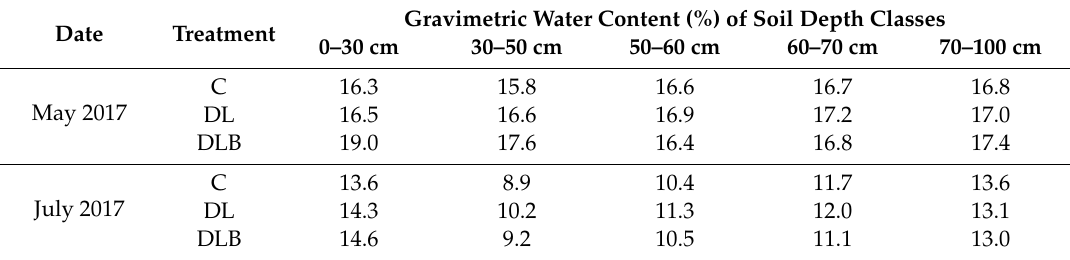
Table 6. Gravimetric soil water content in five soil depth classes. Different letters indicate significant differences within one sampling date (Tukey’s test, p < 0.05). In May 2017 (only two field replicates sampled) and July 2018 (samples from three field replicates merged) statistical evaluation was not possible. C: control, DL: deep loosening with tine, DLB: deep loosening with tine and bio compost.